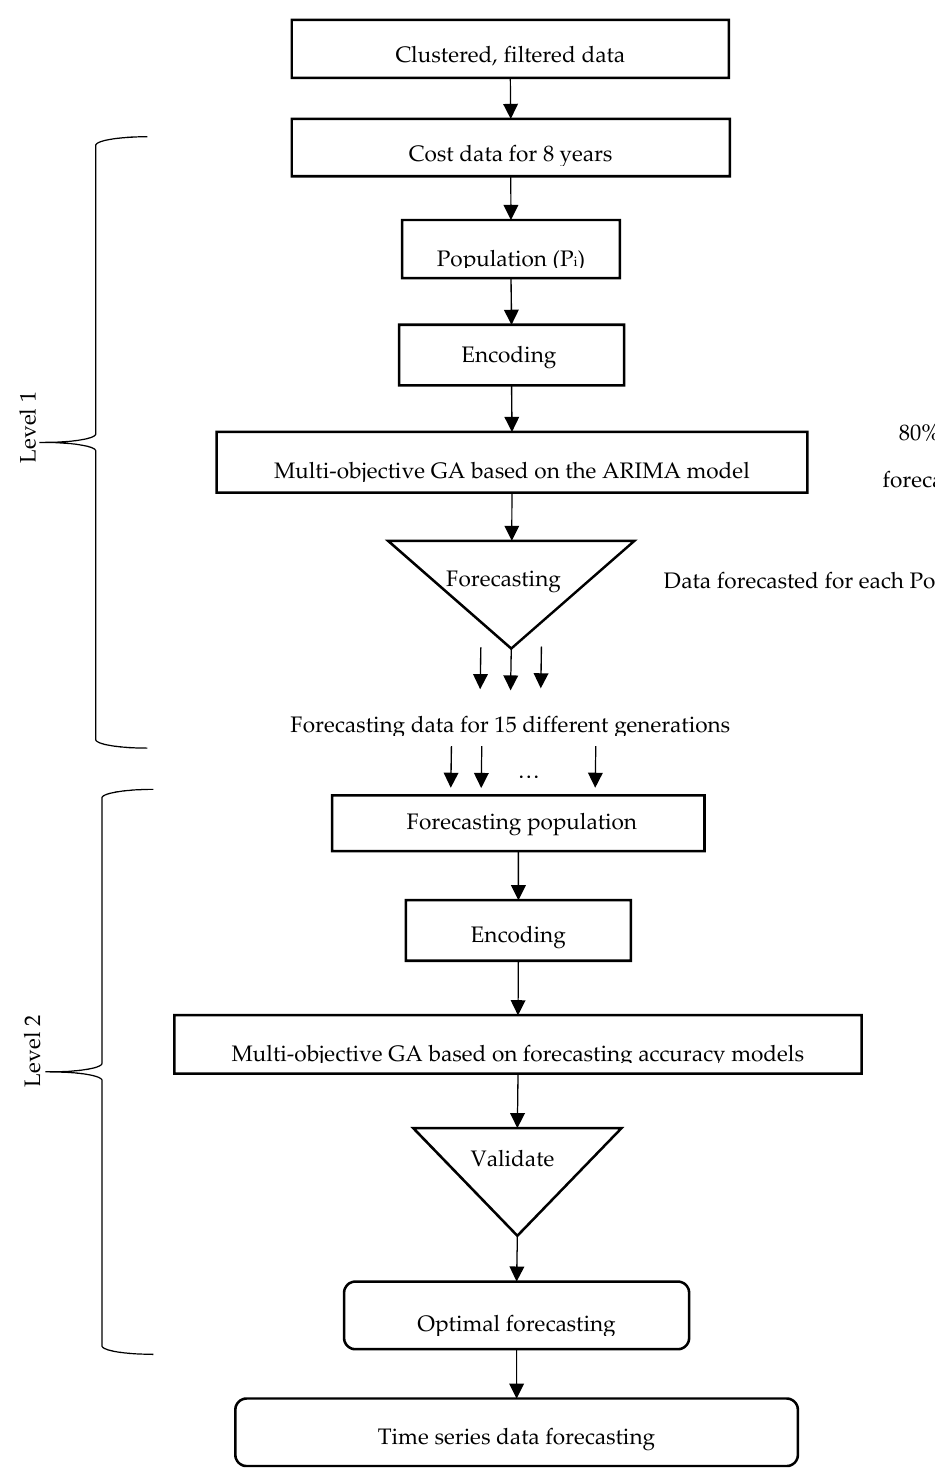
Figure 1. Two ‐ level system of multi ‐ objective GAs. Figure 1. Two-level system of multi-objective